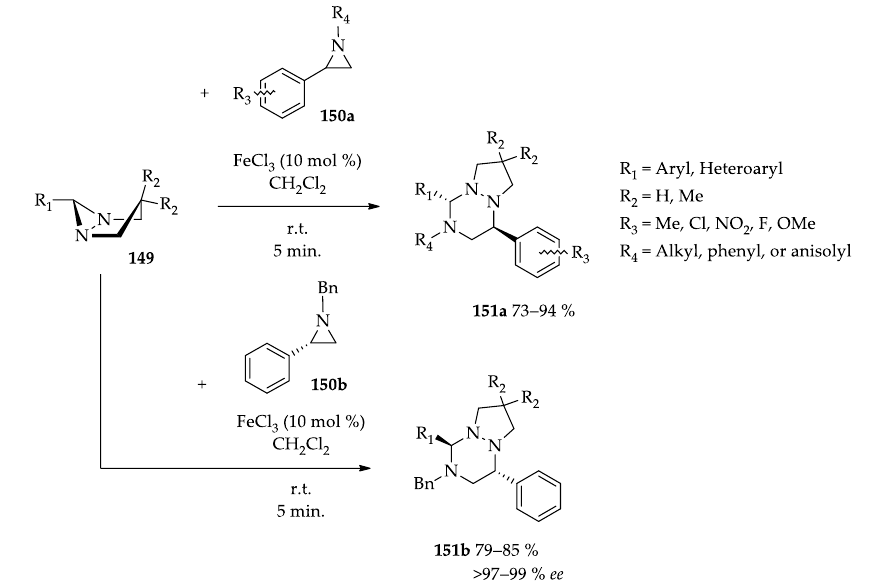
Scheme 11. Iron-catalyzed cycloaddition of diaziridines 149 with aziridines 150